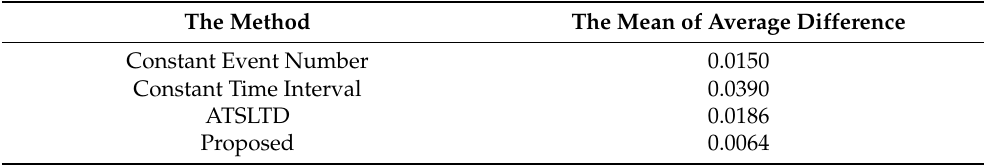
Table 1. The mean value of the difference between the information entropy of virtual frame obtained by the four methods and APS